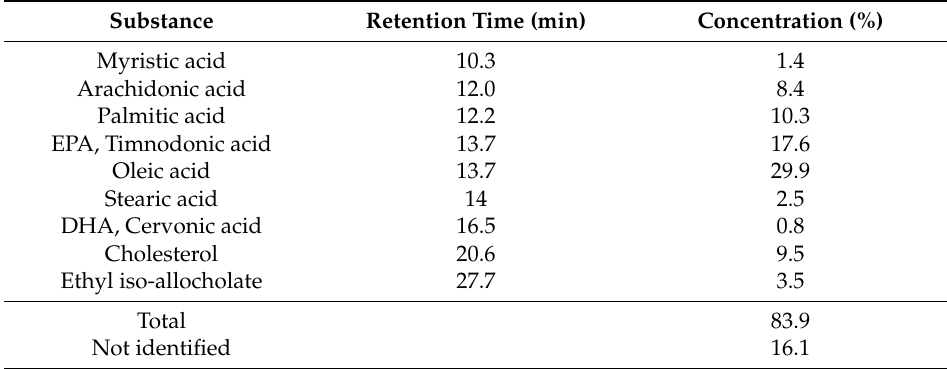
Table 1. Chemical characterization by GC-MS of the bullfrog oil obtained by hot extraction (BOH). Substance Retention Time (min) Concentration (%) Myristic acid 10.3 1.4 Arachidonic acid 12.0 8.4 Palmitic acid